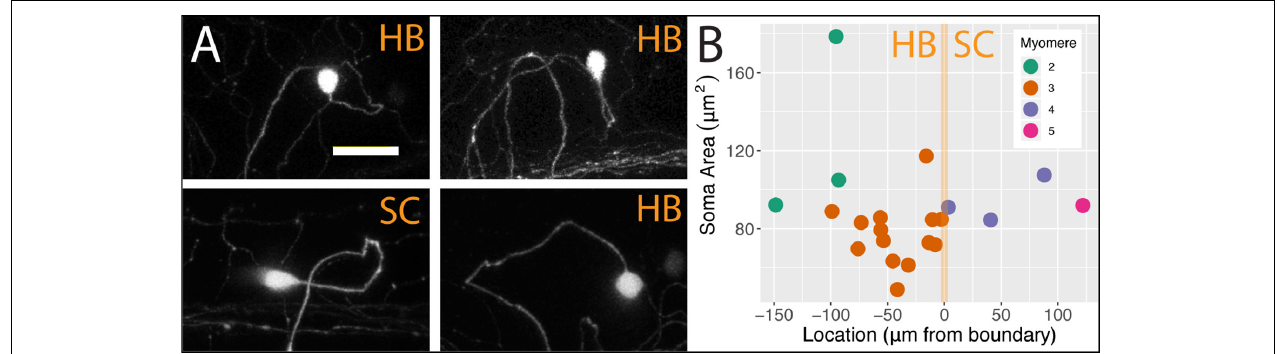
FIGURE 3 | FSNs exhibit a variety of soma morphologies. (A) The four main FSN soma morphologies clockwise from top left: small spherical hindbrain (HB), small teardrop HB, rounded HB with dorsal projection, and a classic dorsally located RB with its dorsoventrally compressed shape resulting in elongation along the anteroposterior axis. The three hindbrain morphologies are apparent across cells associated with myomeres two and three. (B) FSNs are distributed across myomeres two through five, and they show no significant trends in soma size or distribution patterns across the anterior to posterior axis within any of these myomeres. FSNs exhibit no trends with regard to the hindbrain/spinal cord transition area (indicated in orange). Negative numbers are consistent with a hindbrain location, and positive numbers indicate a spinal cord location. Most of the cells innervating the fin are found in myomere three. Anterior is to the left, dorsal is up in (A) . Scale is 25 microns in (A)